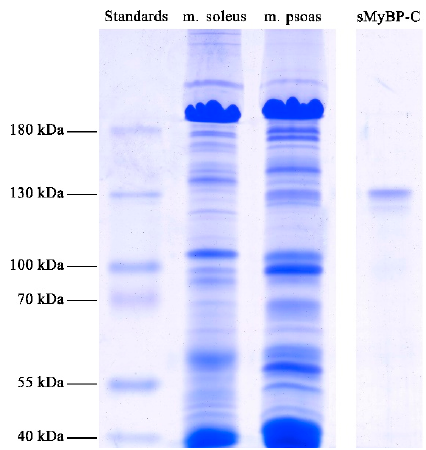
1THBQ23ezEtVeIx3_WKw6Py2Ql0ixHUVH/view?usp=sharing.